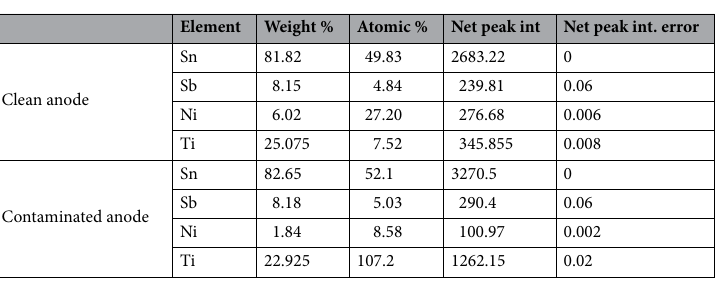
Table 1. Weight and atomic percentages and the peak intensities in EDS spectra of the anodes.